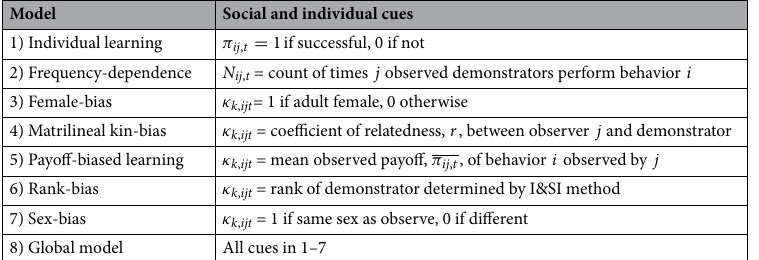
Table 3. Individual information and social cues used in the EWA models. Models 2–8 also incorporate individual experience from model 1. Information observed at timestep t for models 2–8 was the mean of each cue, κ evaluated in the 20 min prior to timestep